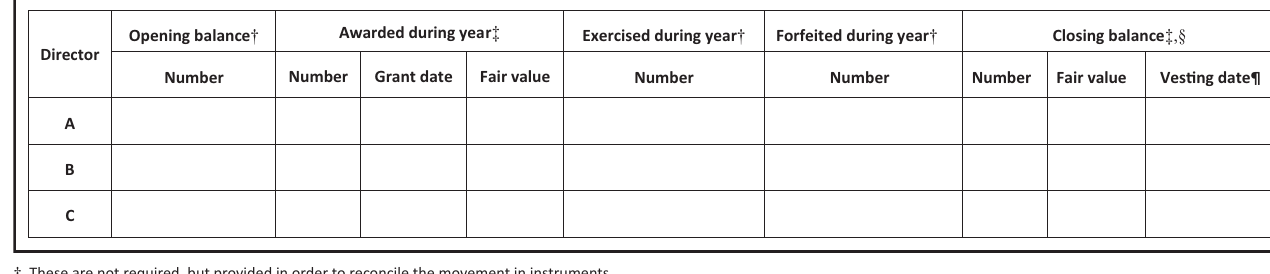
FIG URE 1: Best practices disclosure example: Instruments not yet vested.